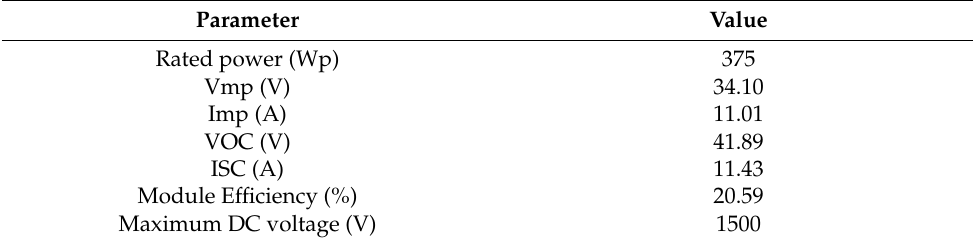
Table 1. Main characteristics of the PV panels used for simulations.